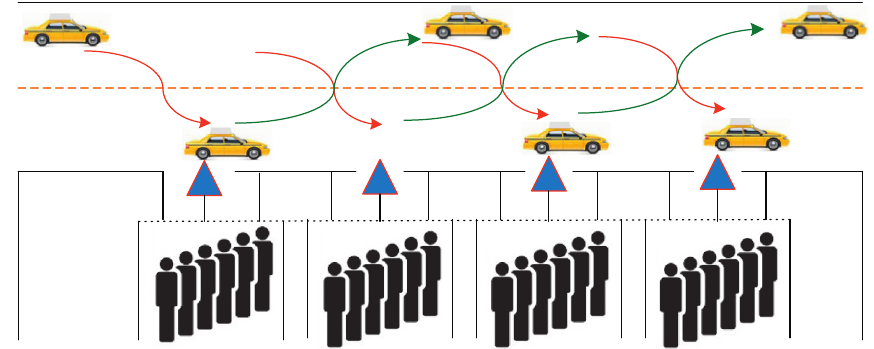
Figure 4: Taxi points in the boarding